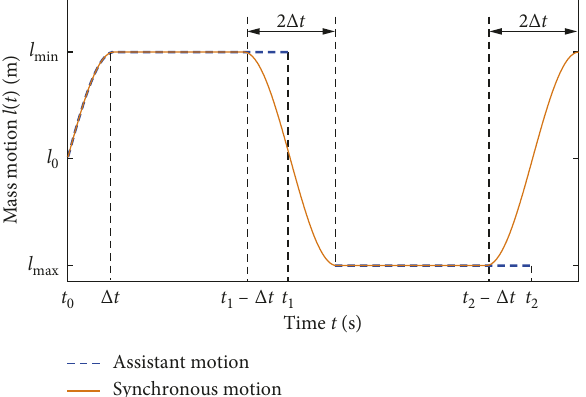
Figure 9: Nonsynchronous motion. (a) The continuous pendulum behavior θ and the mass motion l ; (b) the partial enlargement of (a).